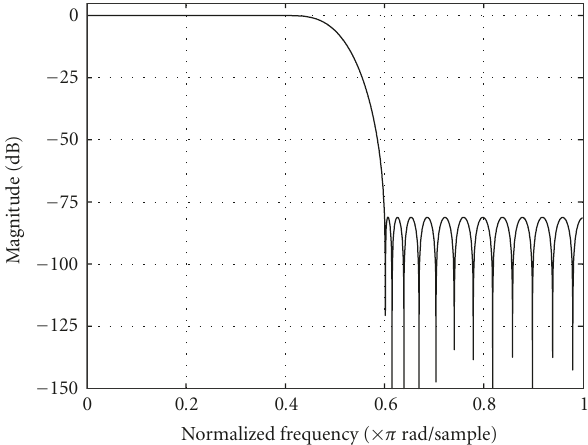
Figure 5: Magnitude response of the 47-tap FIR filter; ω p = 0 . 4 and ω s = 0 .